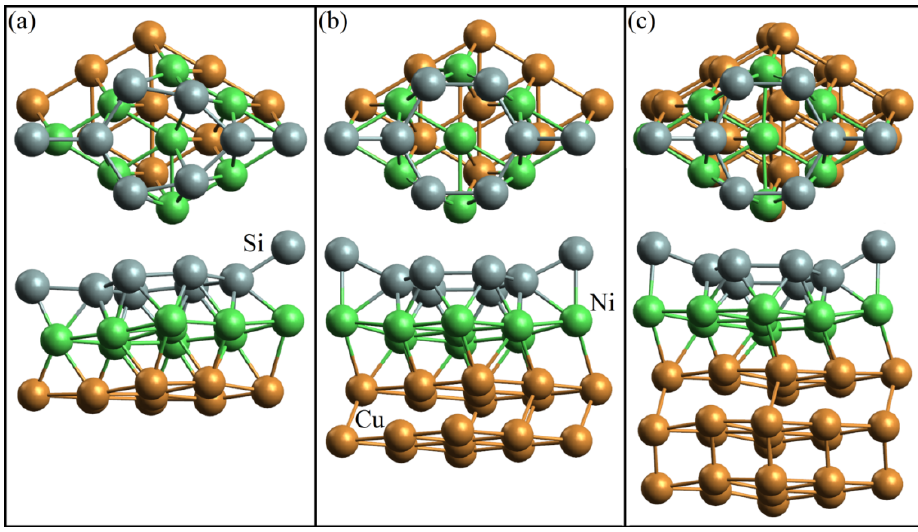
Figure A1. Geometric structure of silicene systems on ( a ) single-layer, ( b ) two-layer, and ( c ) three-layer copper substrates with an intermediate nickel layer between silicene and copper.